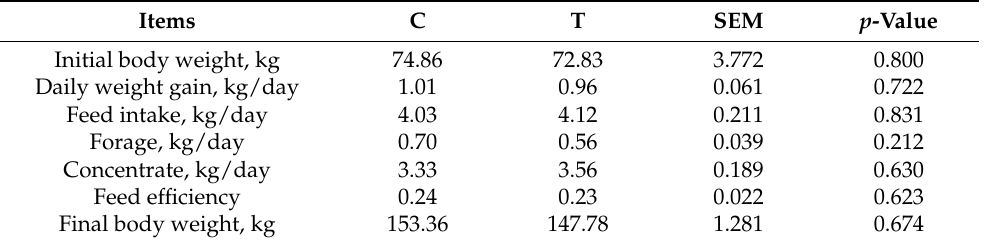
Table 4. Effects of supplemental resveratrol on the growth performance of Hanwoo calves.